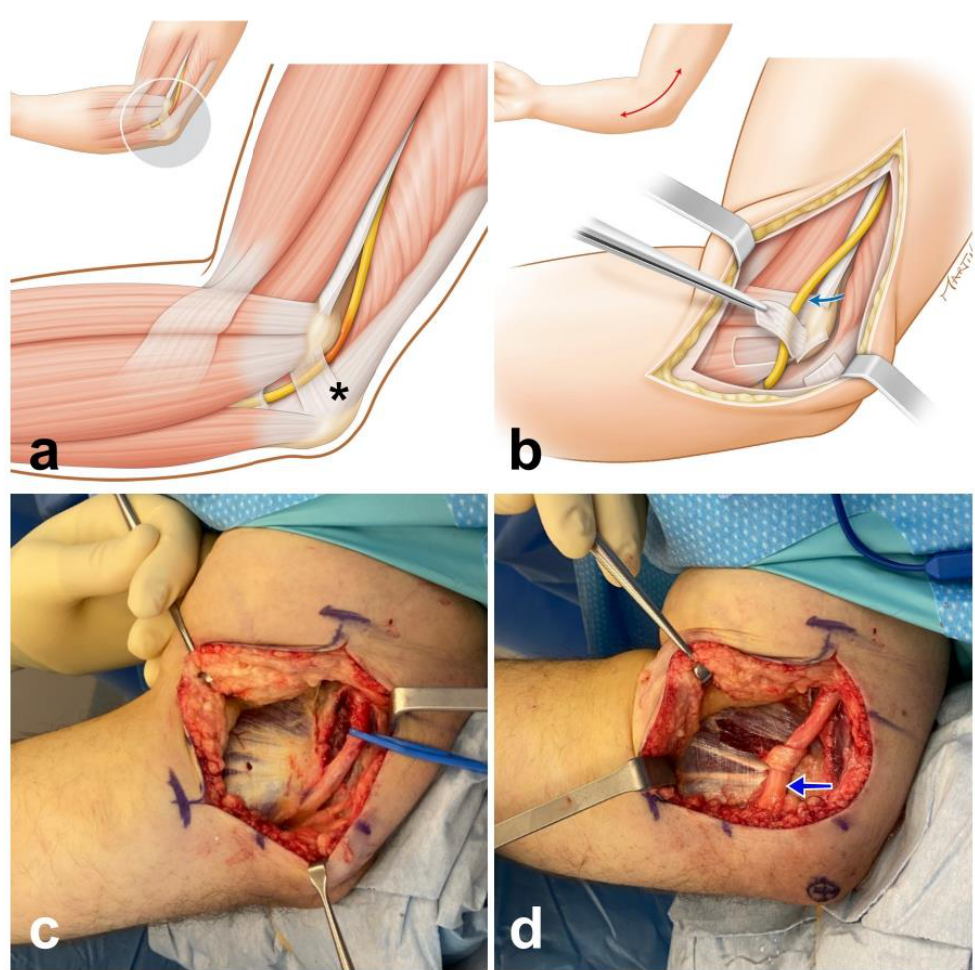
Figure 1. Sketches detailing ulnar nerve (yellow) entrapment in the cubital tunnel ( a ), which is where Obsorne’s ligament is located (asterix). The ulnar nerve is transposed anteriorly (blue arrow) and stabilized with a fascial sling ( b ). Intraoperative photograph after complete release of all points of ulnar nerve with elevation of the soft tissue above the flexor-pronator muscle mass ( c ); the ulnar nerve is transposed subcutaneously and stabilized anteriorly with a fascial sling ( d ).